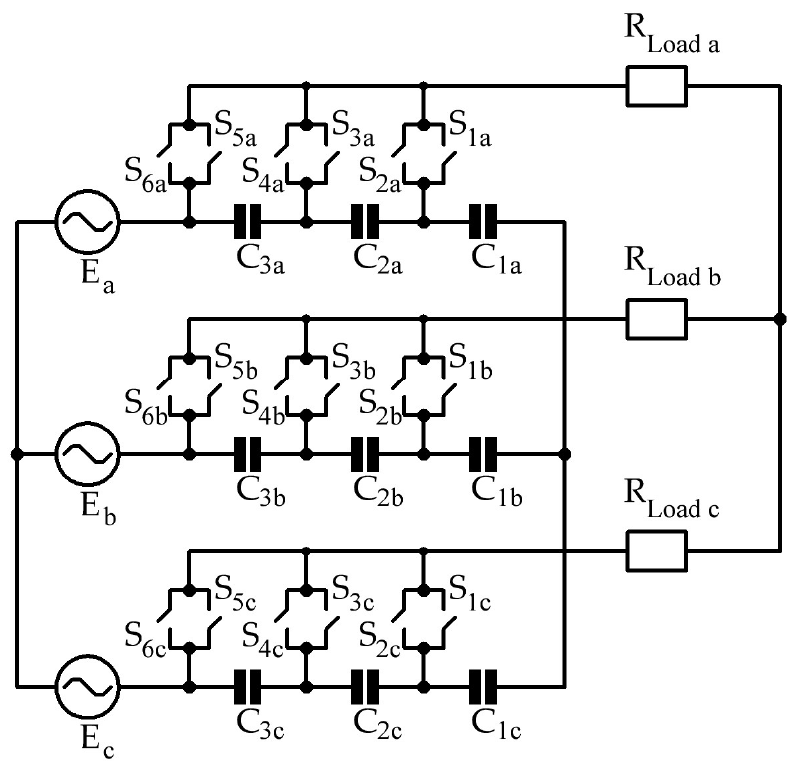
Figure 2. Electrical diagram of three-phase converter.